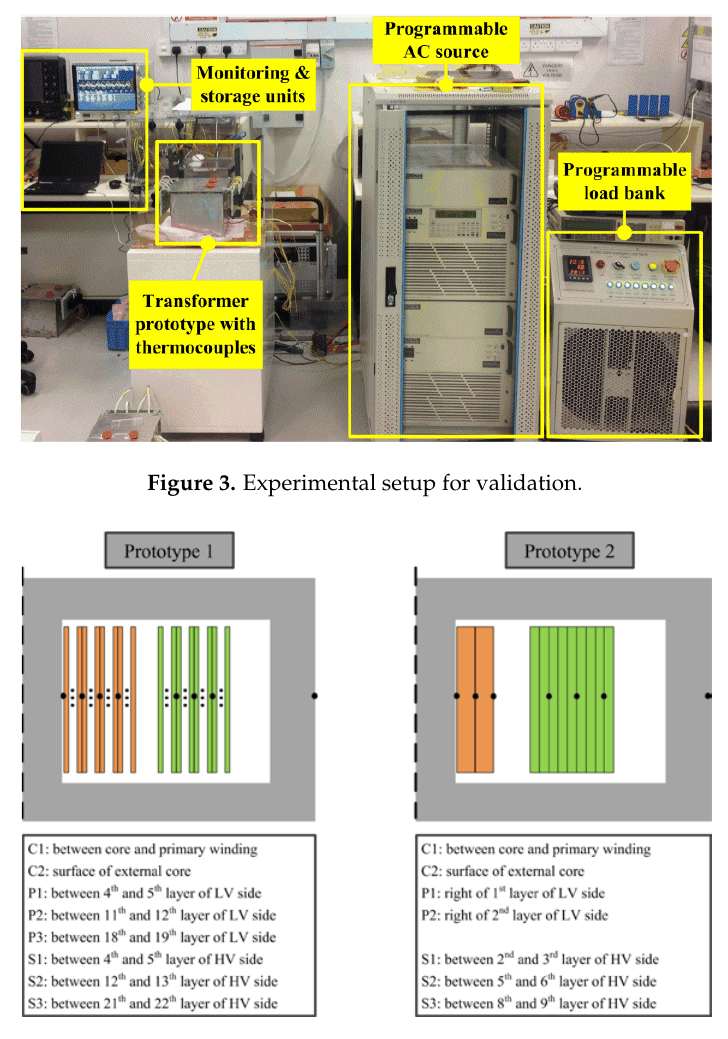
Figure 4. Thermocouple locations (Note: the figure does not represent the real geometry of transformer design; it is a diagram to identify the relative locations of temperature measurement points).